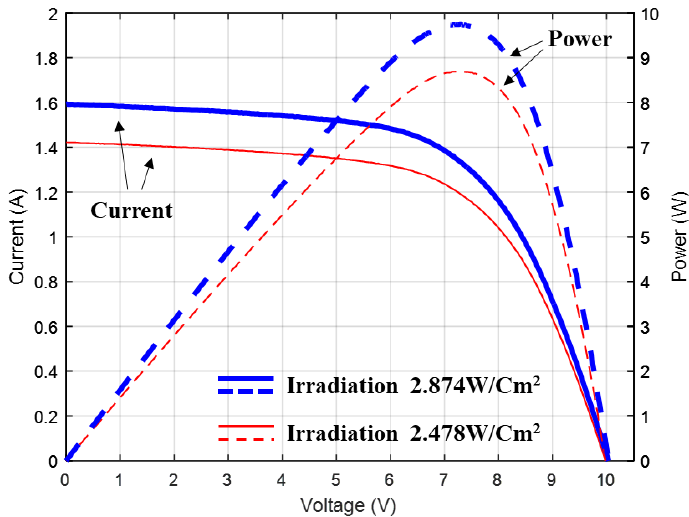
Figure 3. Voltage–current and voltage–power characteristics based on laser power of PV module.